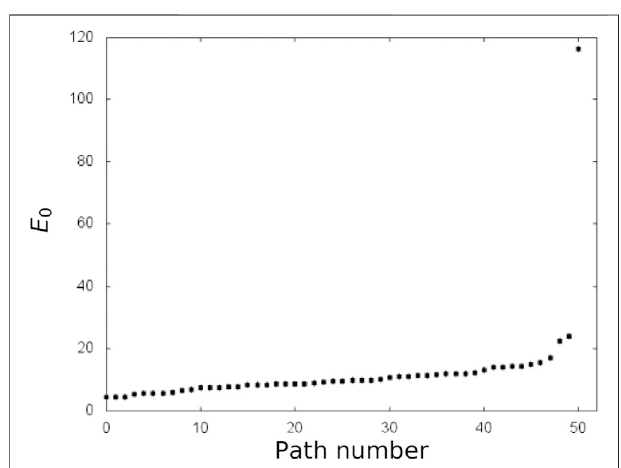
FIGURE10 | Theweight E O ranging from the most optimal (No. 0)to the least optimal (No. 50) for paths between intervals on different edgesas shown in Figure 9